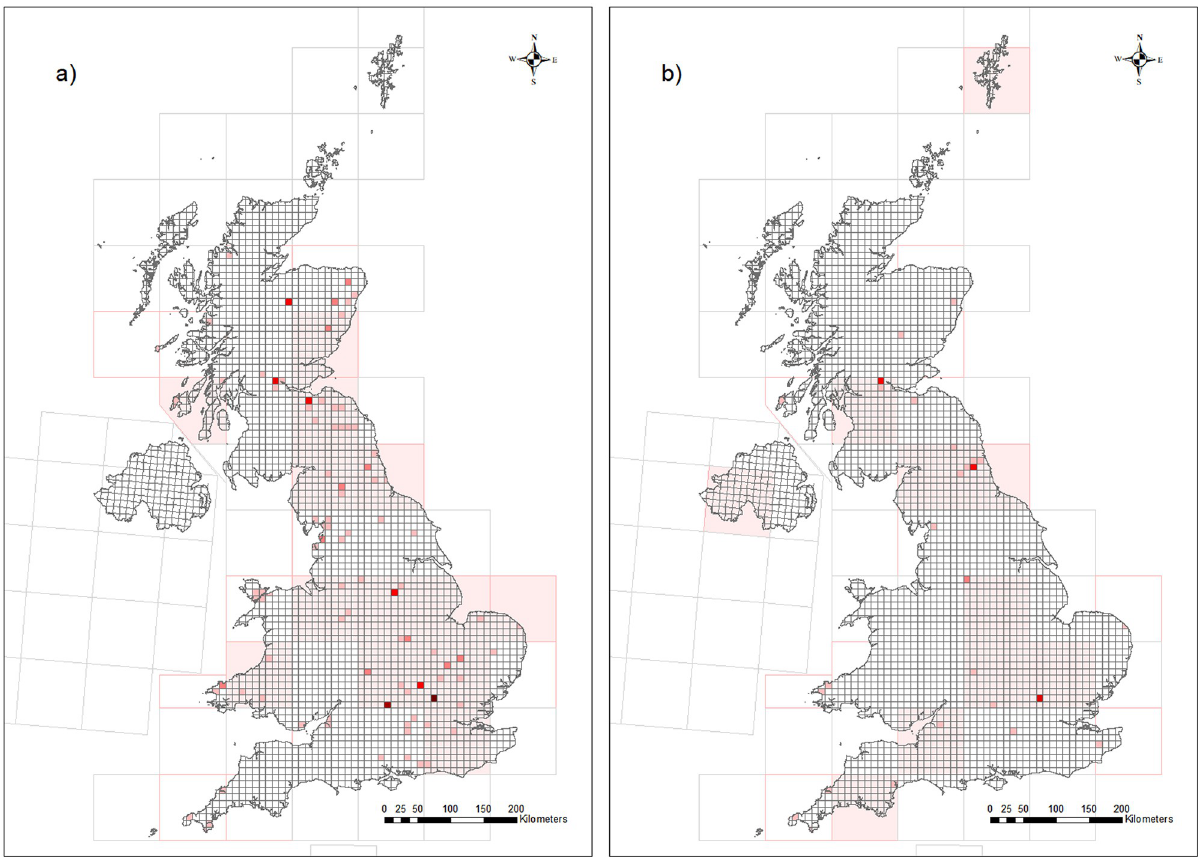
Fig 1. The geographic spread of a) earthworm data and b) tipulid data extracted from the literature over the UK. The red 10 km squares represent locations sampled for each study and darker squares represent data from multiple studies. The light red 100 km squares are either inaccurate study locations or studies that cover a wider area than the 10 km. © 2018–2022 GADM—license. a)